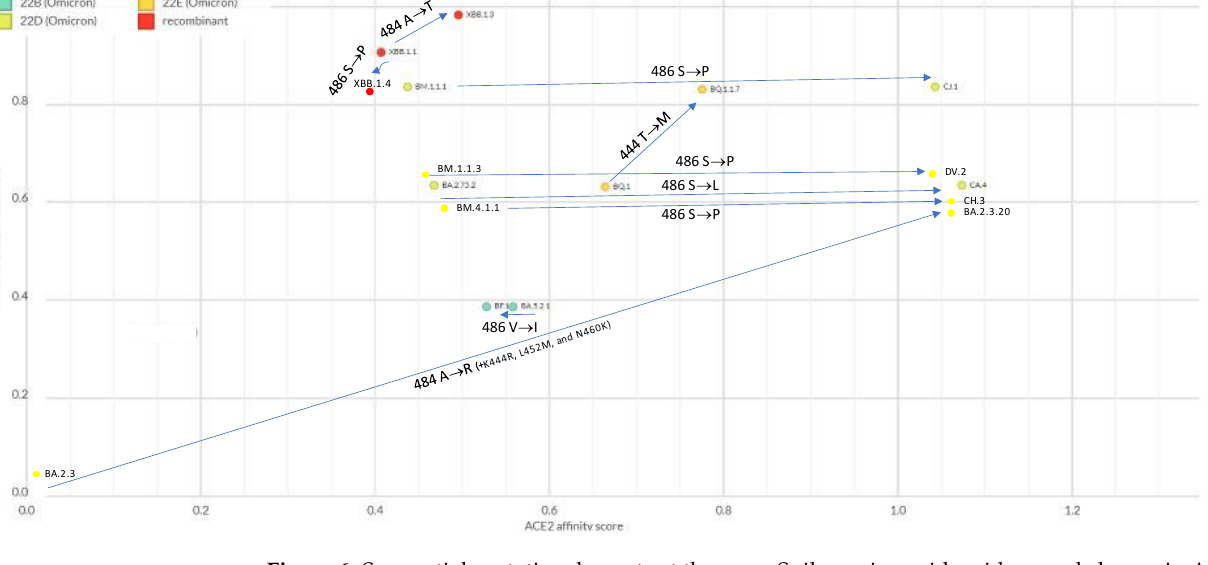
Figure 6. Sequential mutational events at the same Spike amino acid residues and change in ACE2 affinity score (as calculated here: https://github.com/jbloomlab/SARS-CoV-2-RBD_DMS_Omicron/blob/main/results/final_variant_scores/final_variant_scores.csv (accessed on 26 December 2022)). Chart created on NextStrain [31] (https://next.nextstrain.org/staging/nextclade/sars-cov-2/21L?gmin=15&l=scatter&scatterX=ace2_binding&scatterY=immune_escape&showBranchLabels=all (accessed on 26 December 2022)).